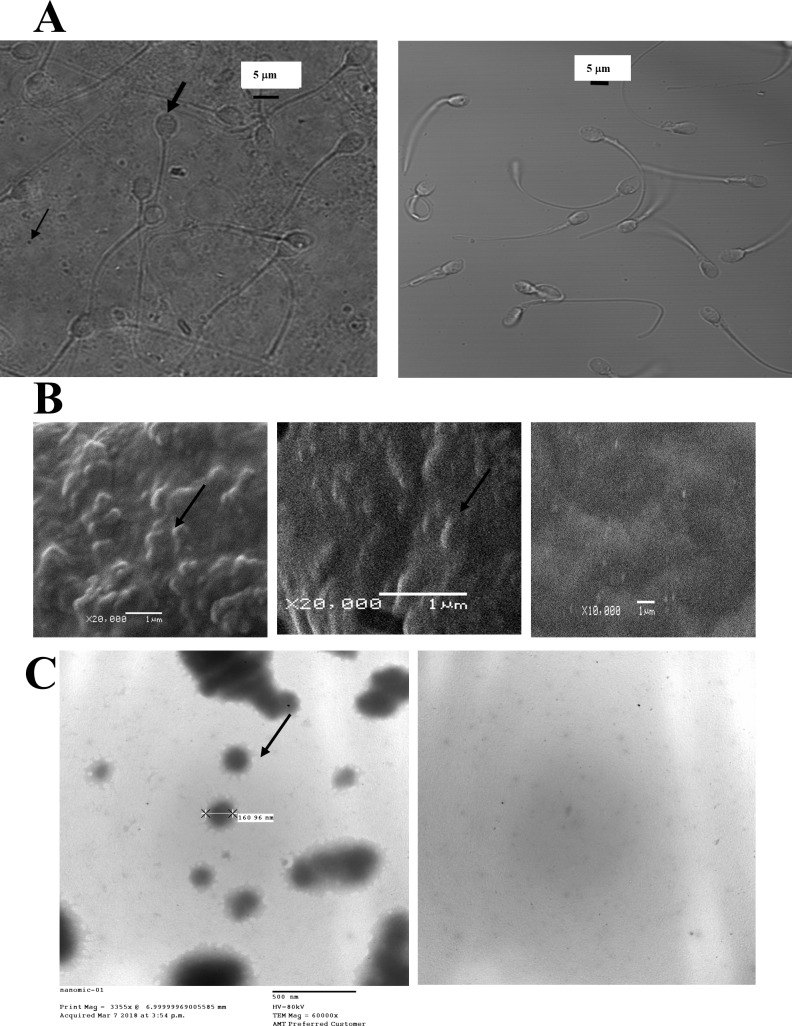
Aggregation of glycerophospholipids into sub-μm-sized micelles.(A) Images of sperm and GPL micelles in a confocal microscope with visible light. Precipitated ultra-sonicated sub-μm-sized GPL micelles (thin arrow) with human sperm (thick arrow) after a 6-h incubation with GPL (left), or human sperm after a similar incubation in media without GPL (right). (B) Precipitated GPL micelles seen in a Scanning Electron Microscope. The left image shows the micelles as protruding images from a thin-layered film (thin arrow). In other regions, isolated micelles can also be seen (middle image, thin arrow). The control image without GPL micelles is shown to the right. (C) GPL micelles observed in a transmission electron microscope with negative staining. To the left single GPL micelles (thin arrow) can be seen, and some micelles colliding and forming larger micelles can be observed. A background image without GPL micelles is shown to the right.